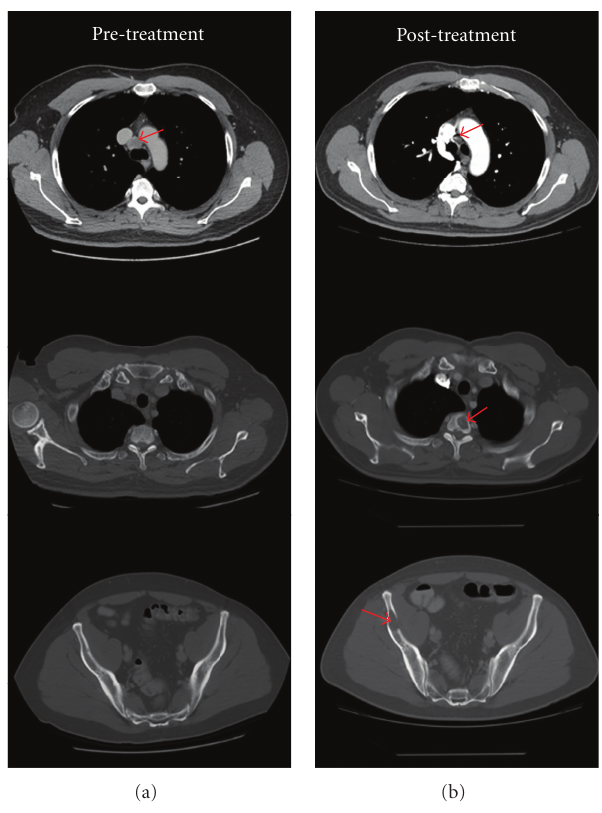
Figure 2: Patient with partial response in lymph nodes but progression in bone. CT scans before (a) and after (b) 6 months of therapy with a TKI. The patient had a partial response in mediastinal and hilar adenopathy but progression in bone with cortical destruction. The patient’s bone lesions were irradiated, and he was restarted on the TKI. The patient continues on the TKI after 24months and has no further evidence of